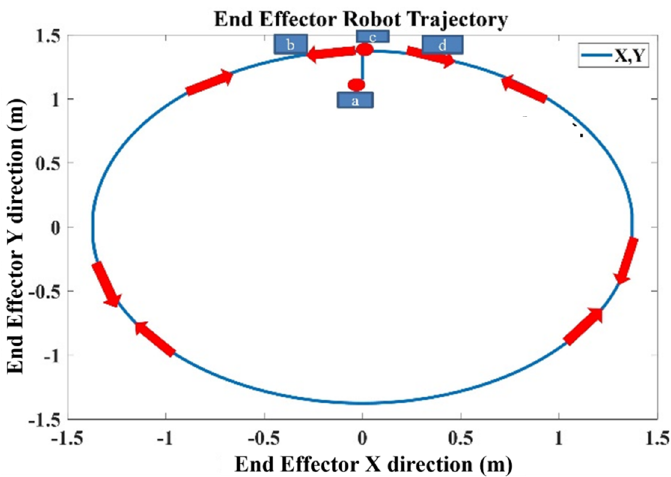
Figure 13. Robot end-effector trajectory. (a) The robot end effector’s starting position; (b) going left and toward the wall of RVI; (c) completing the scanning of RVI; (d) after completing scanning of the RVI, it reverses direction and reaches its final position.